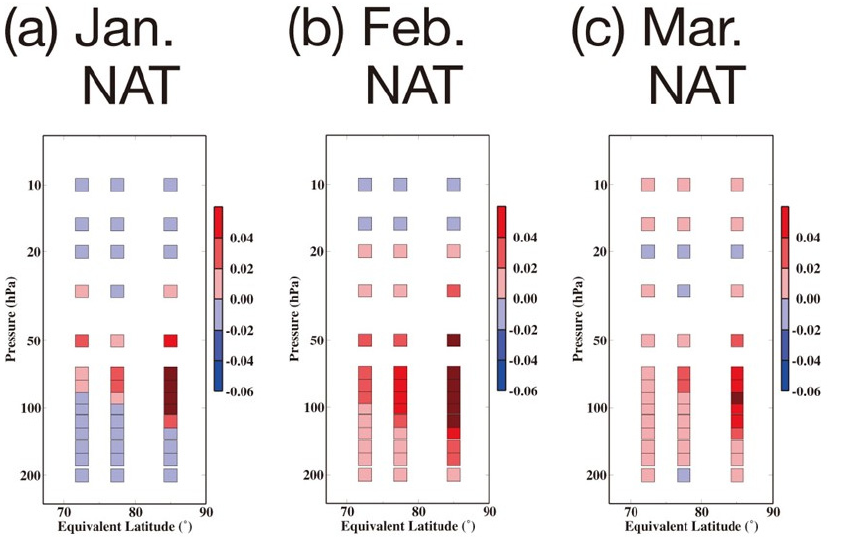
Figure 10. Equivalent latitude–height section of the NAT surface area anomaly (10 − 9 cm 2 cm − 3 ) in ( a ) January, ( b ) February, and ( c ) March for QBO-W/S min from the REF-C1SD experiment.